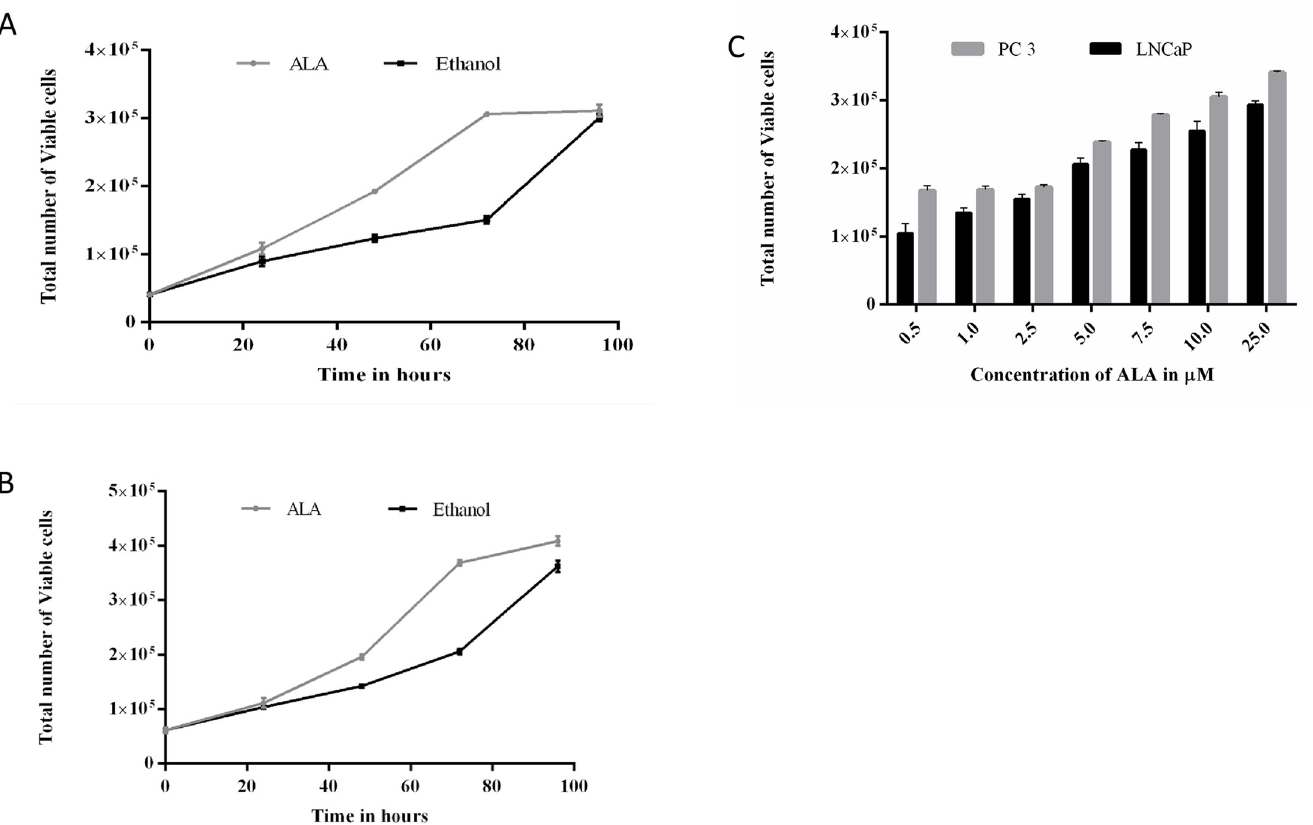
Fig 8. Effect of ALA on proliferation of LNCaP and PC-3 cells. (A&B) Proliferation of LNCaP and PC-3cells treated with different concentrations of ALA or Ethanol (solvent control) measured by using countess in cell viability analyzer (Invitrogen) over 72 h.(C&D) Time dependent effect of ALA on proliferation of LNCaP and PC-3 cells has been performed by measuring cell proliferation of ALA treated cells for 0 to 96 h. Initial number of cells seeded for assay was considered for 0 h.